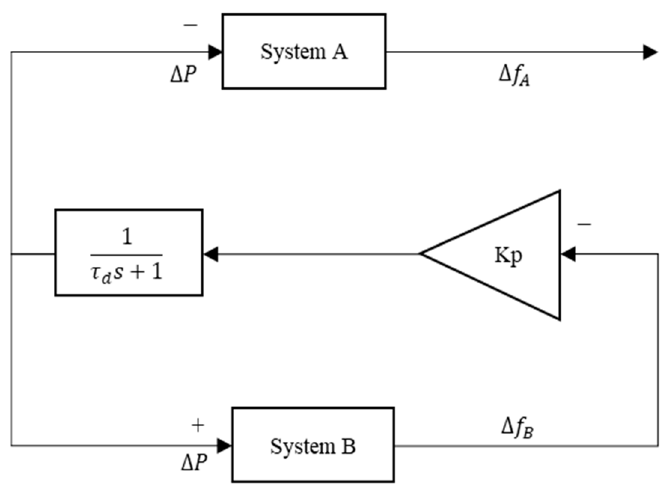
Figure 3. E-FCR control through HVDC operation.